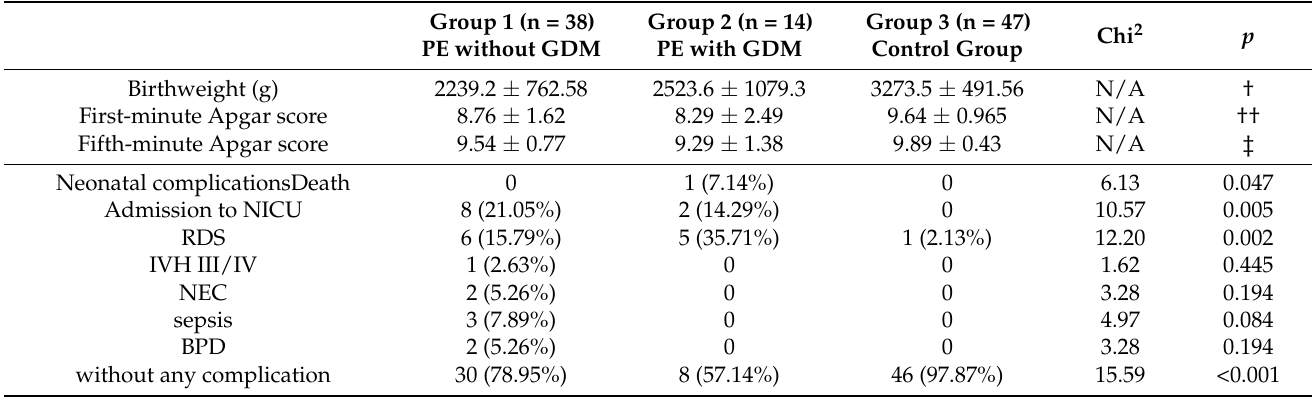
Table 2. Neonatal outcomes.